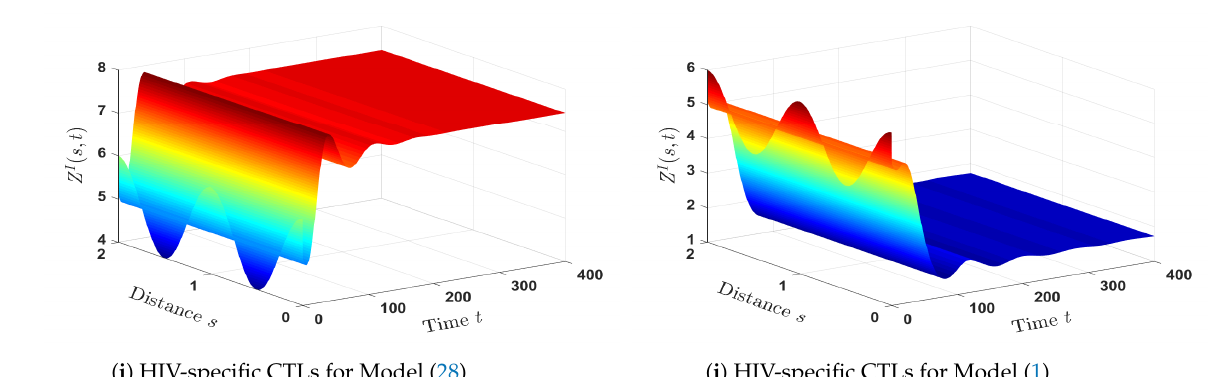
Figure 9. Comparison between the solutions of two models: HIV mono-infection Model (28) and HTLV/HIV co-infection Model (1), under the initial conditions (26) and boundary conditions (27), taking ω 1 = 0.0006, ω 2 = 0.0002, ω 3 = 0.0004, ω 4 = 0.07, υ 1 = 0.05, υ 2 = 0.5.